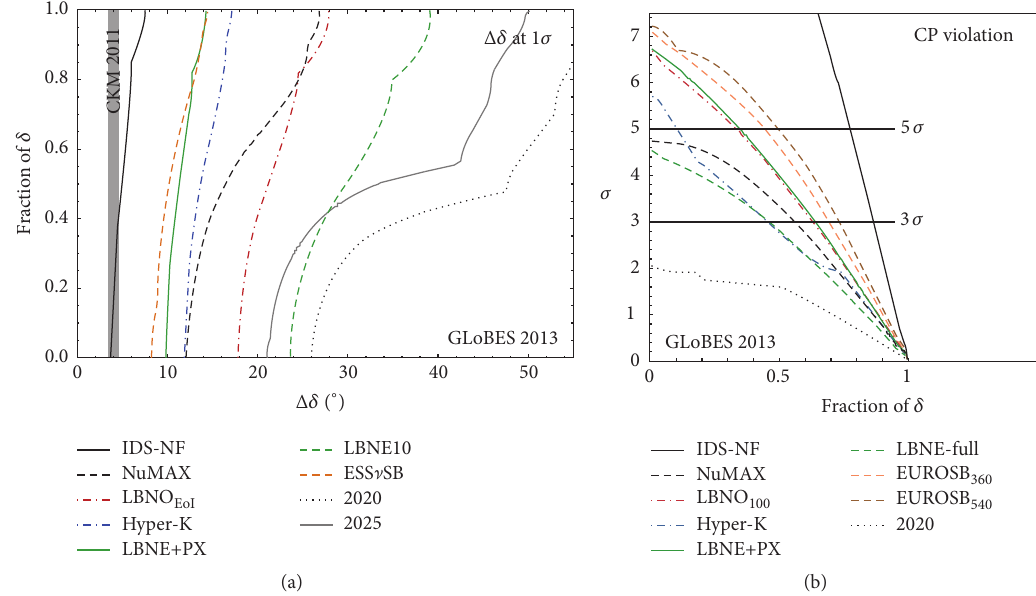
Figure 10: In (a) the 1 𝜎 error in the determination of 𝛿 CP is shown (horizontal axis) as a function of the 𝛿 CP fraction for which this accuracy can be reached (vertical axis) [26]. (b) shows with what level of significance in terms of number of standard deviations 𝜎 that leptonic CP violation can be discovered (vertical axis) versus the fraction of the total range of possible values for 𝛿 CP (horizontal axis) [9]. The systematic errors used to produce these plots are those shown in the left column (SB Def.) of Table